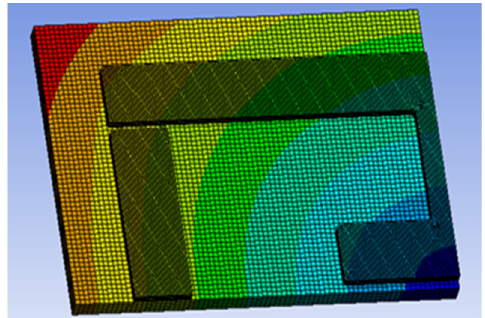
Figure 9. FE model with deformation contour plot (images courtesy of ANSYS Inc). Table 6. FEA sensor specifications.